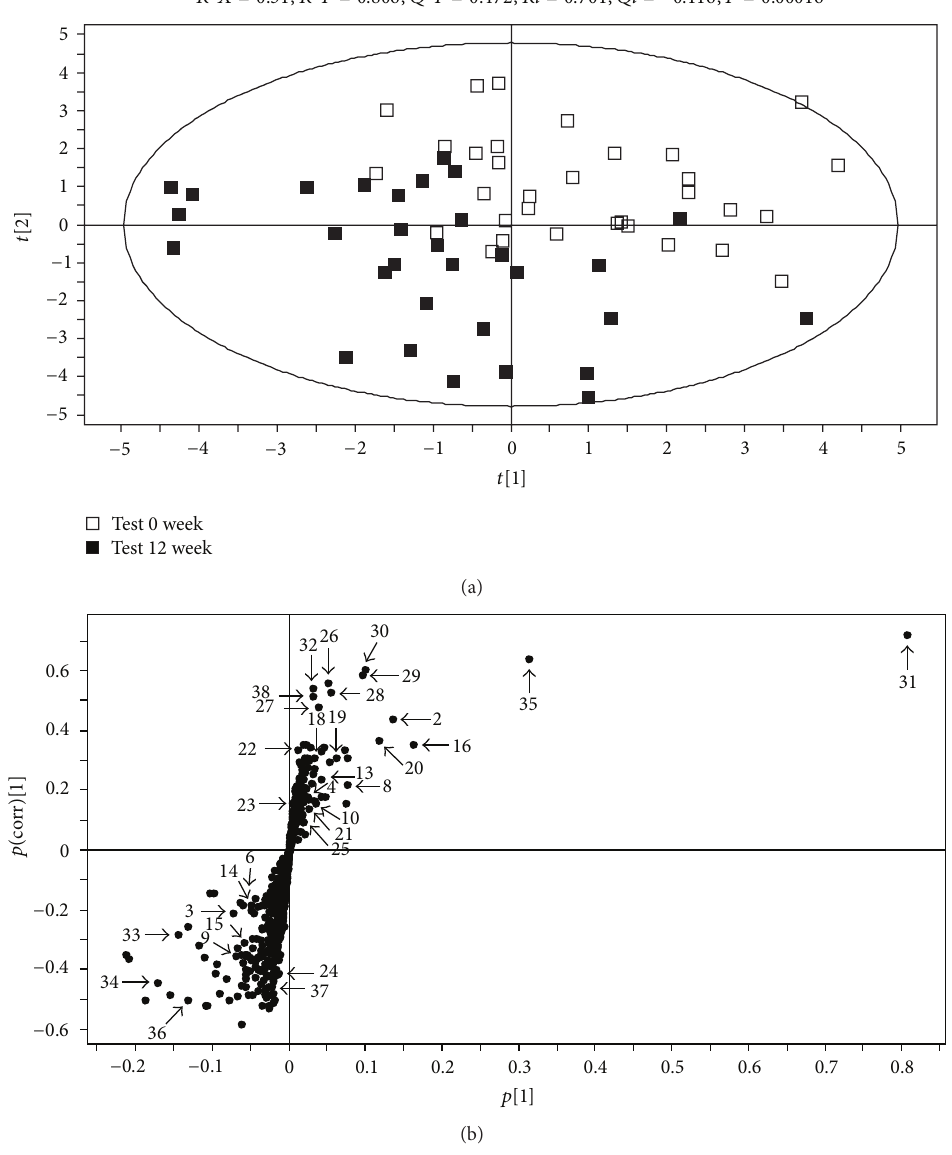
Figure 2: (a) Partial least-squares discriminant analysis (PLS-DA) scores plot (a) obtained from the mass spectrometry data of the sera from studysubjects. Data allowed clear discriminationbetween thesubjectsatweek 0(opensquare)and atweek 12(filled square).Outlying samples of the ellipse region with the 95% confidence interval were excluded by the Hotelling’s 𝑇 2 test. 𝑅 2 𝑋 , 𝑅 2 𝑌 , and 𝑄 2 𝑌 . The PLS-DA model was validated by a permutation test: 𝑃 -values and intercepts of 𝑅 2 ( 𝑅𝑖 ) and 𝑄 2 ( 𝑄𝑖 ). (b) S-plot covariance [ 𝑝 ] and reliability correlation [𝑝( corr )] from PLS-DA models (b) and loadings plots (b). The numbers for the metabolites are as given in Table